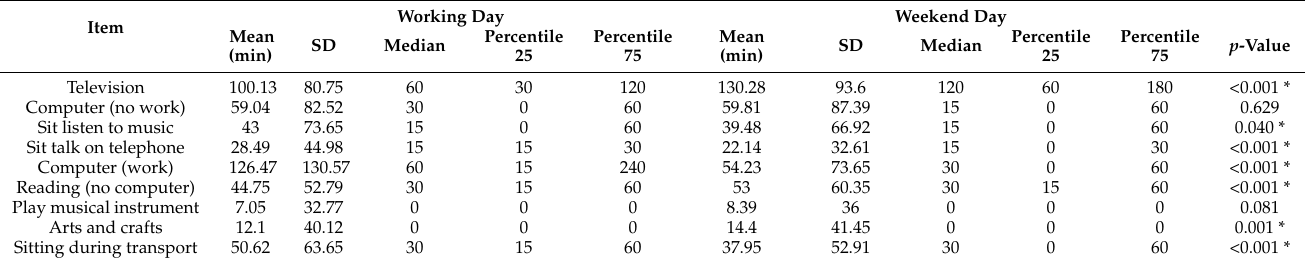
Table 4. Difference between days with respect to time spent sitting per sedentary behavior in the sample.